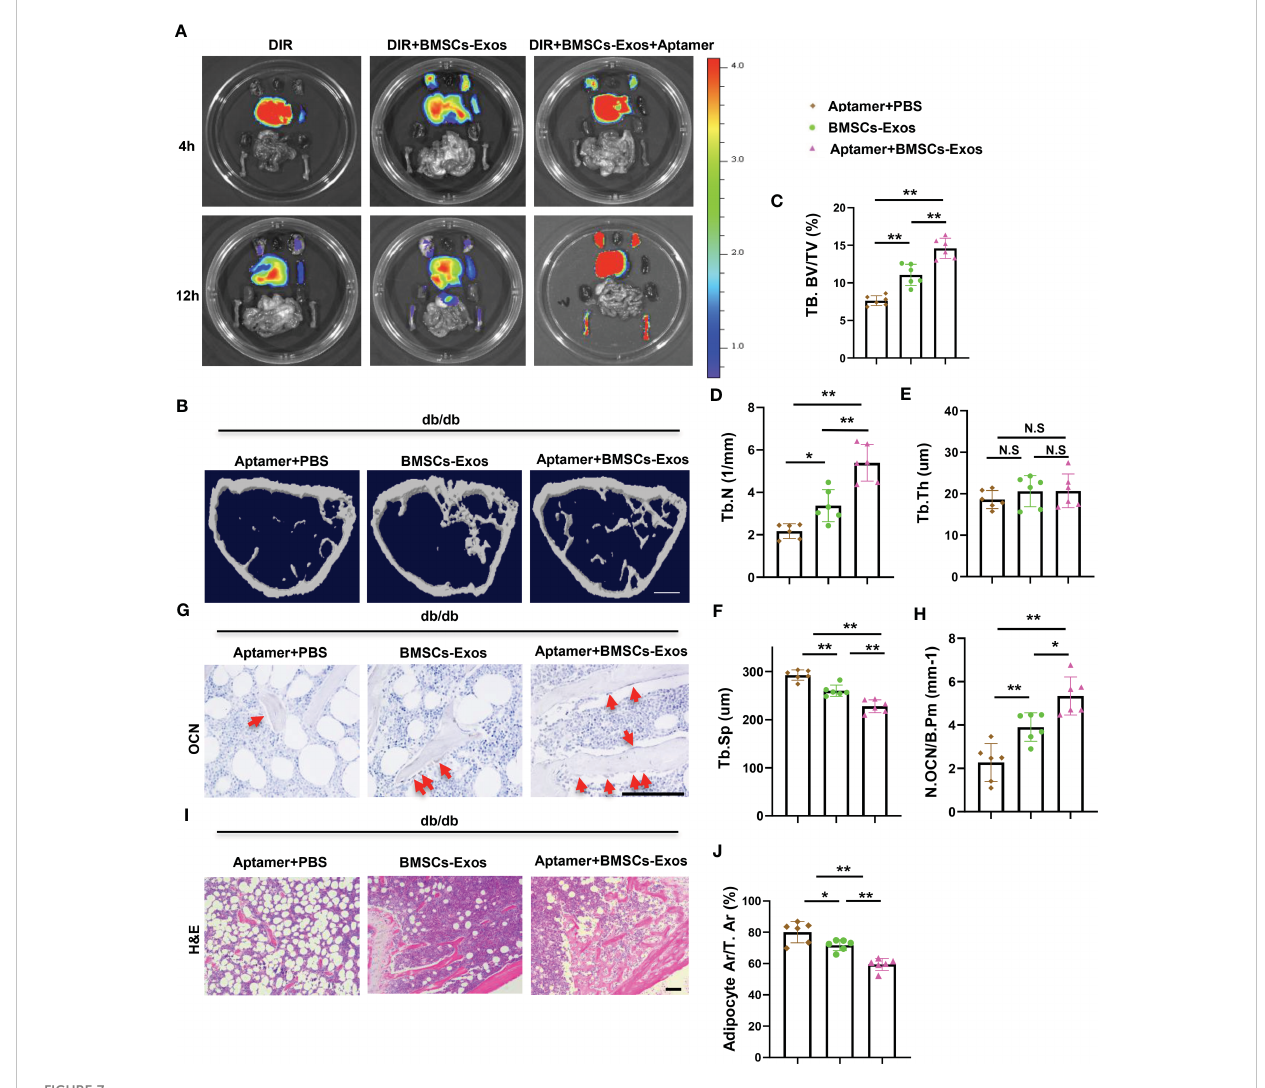
FIGURE 7 Aptamer-BMSCs-Exos alleviated bone-fat imbalance in diabetic mice. (A, B) Conjugate normal BMSCs-Exos with BMSCs-speci fi c aptamer and use near-infrared fl uorescent dye DIR to label BMSCs-Exos, then inject 100ug modi fi ed exosomes to diabetic mice via tail vein. (A) Representative FMT images of the near-infrared fl uorescence signals in organs isolated from mice administered with DIR dye alone, DIR-labeled BMSCs-Exos (DIR- BMSCs-Exos) or aptamer conjugated DIR-labeled BMSCs-Exos (DIR-BMSCs-Exos-Apt) for 4h (up panel) and 12h (bottom panel). (B) Inject 100ug modi fi ed exosomes to diabetic mice via tail vein twice a week, representative m CT images of diabetic mouse femora. Scale bar: 1mm. (C-F) Quantitative m CT analysis of trabecular bone volume (C) , Trabecular bone number (D) , Trabecular thickness (E) and Trabecular separation (F) . (G, H) Representative images of osteocalcin immunohistochemical staining (G) and number of osteoblasts in the distal femur (H) , red arrows represent osteocalcin-positive – staining cells. Scale bar: 100 m M. (I, J) Representative images of H&E staining (I) and area of adipose cells in the distal femur (J) . Scale bar: 100 m M. The data is shown as the mean ± SD, n = 6 per group, * P < 0.05 ** P < 0.01 (ANOVA), n=6 per group. NS, not signi fi